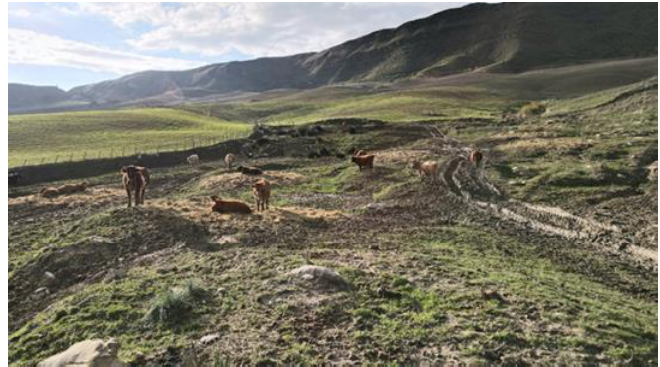
Figure 1. Cattle farm in the mountain areas of central Sicily.